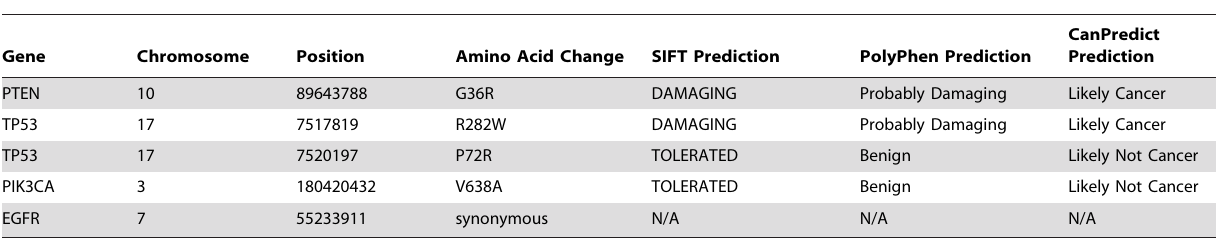
Table 2. Computational classifications of